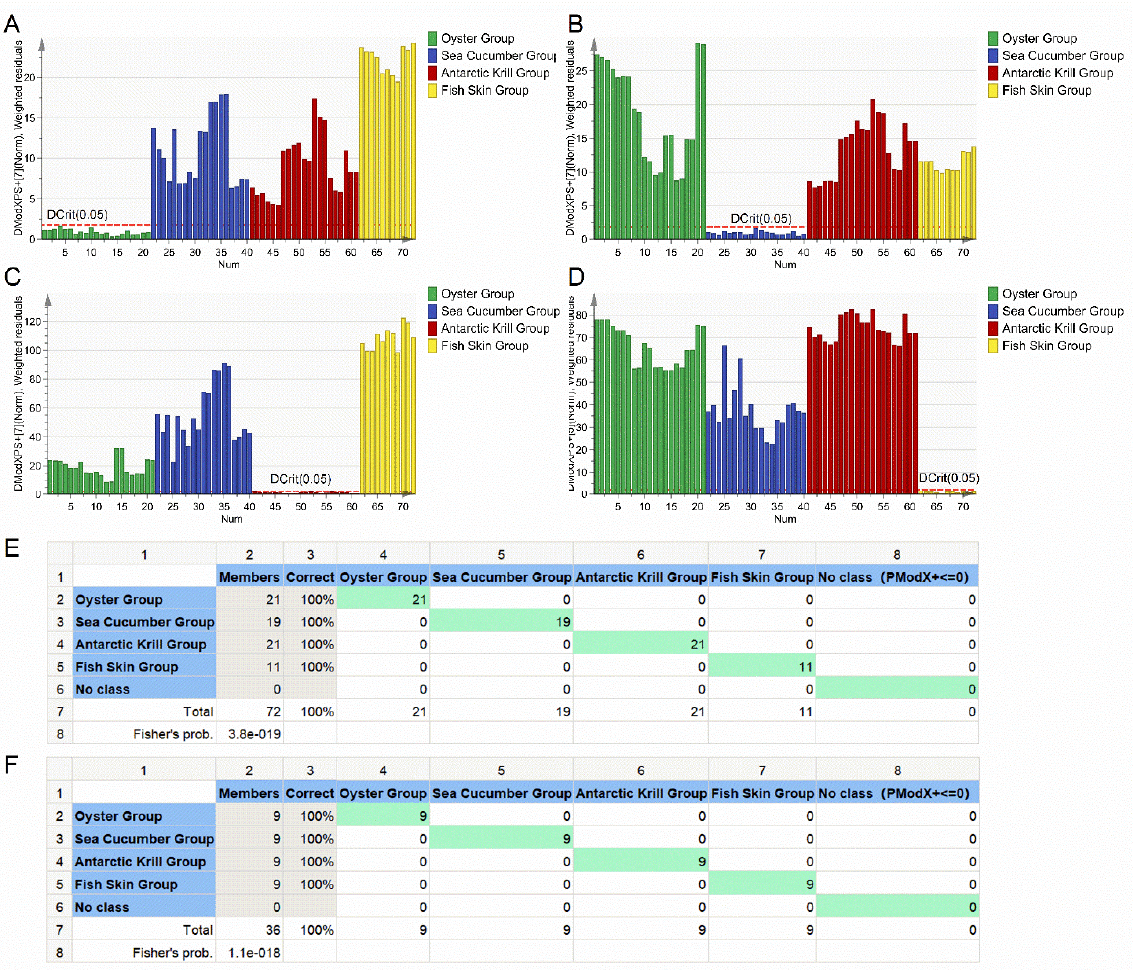
Figure 3. Classification model for the marine-derived peptides. ( A ) DModX PS+ column plot of the oyster group. ( B ) DModX PS+ column plot of the sea cucumber group. ( C ) DModX PS+ column plot of the Antarctic krill group. ( D ) DModX PS+ column plot of the fish skin group. ( E ) Misclassification table of the training set. ( F ) Misclassification table of the prediction set.